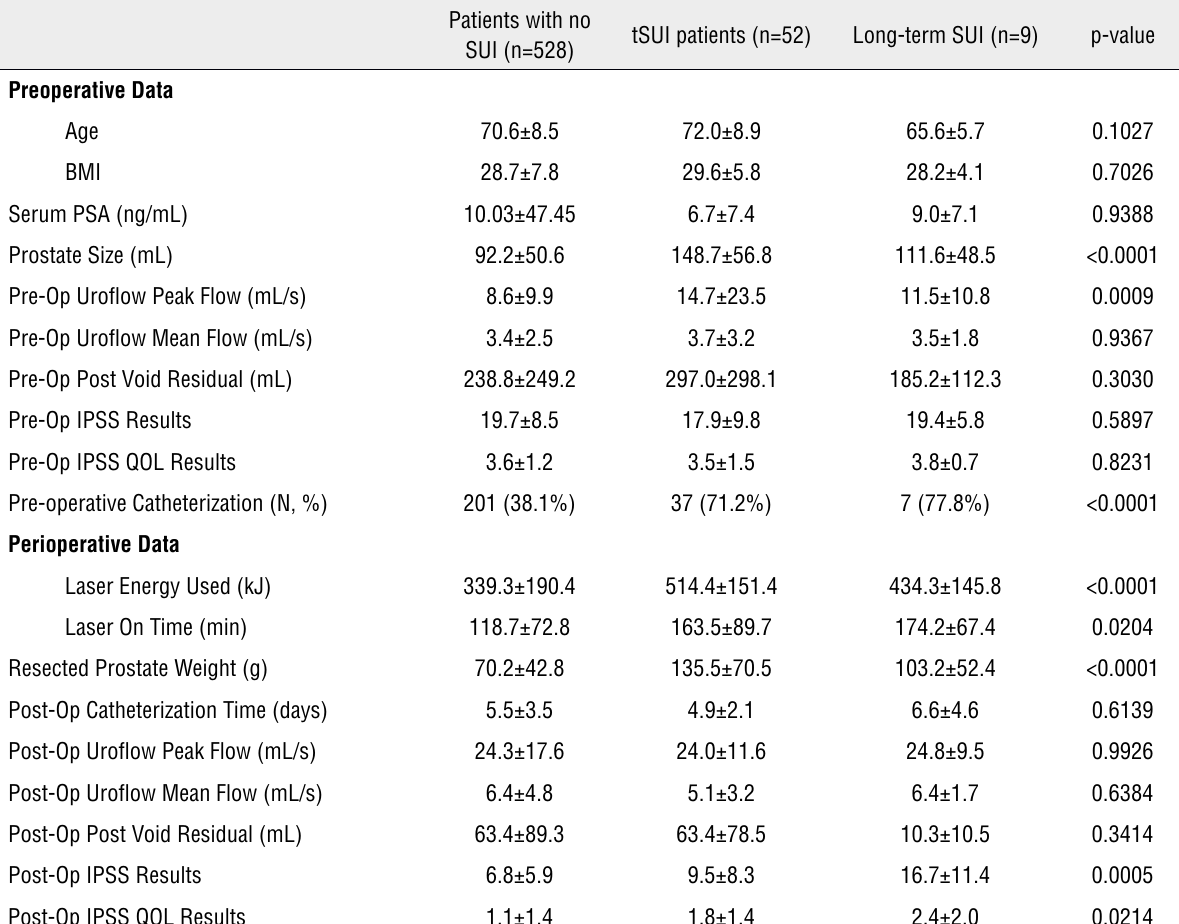
Table 1 - Baseline Characteristics, Preoperative, and Perioperative Data.